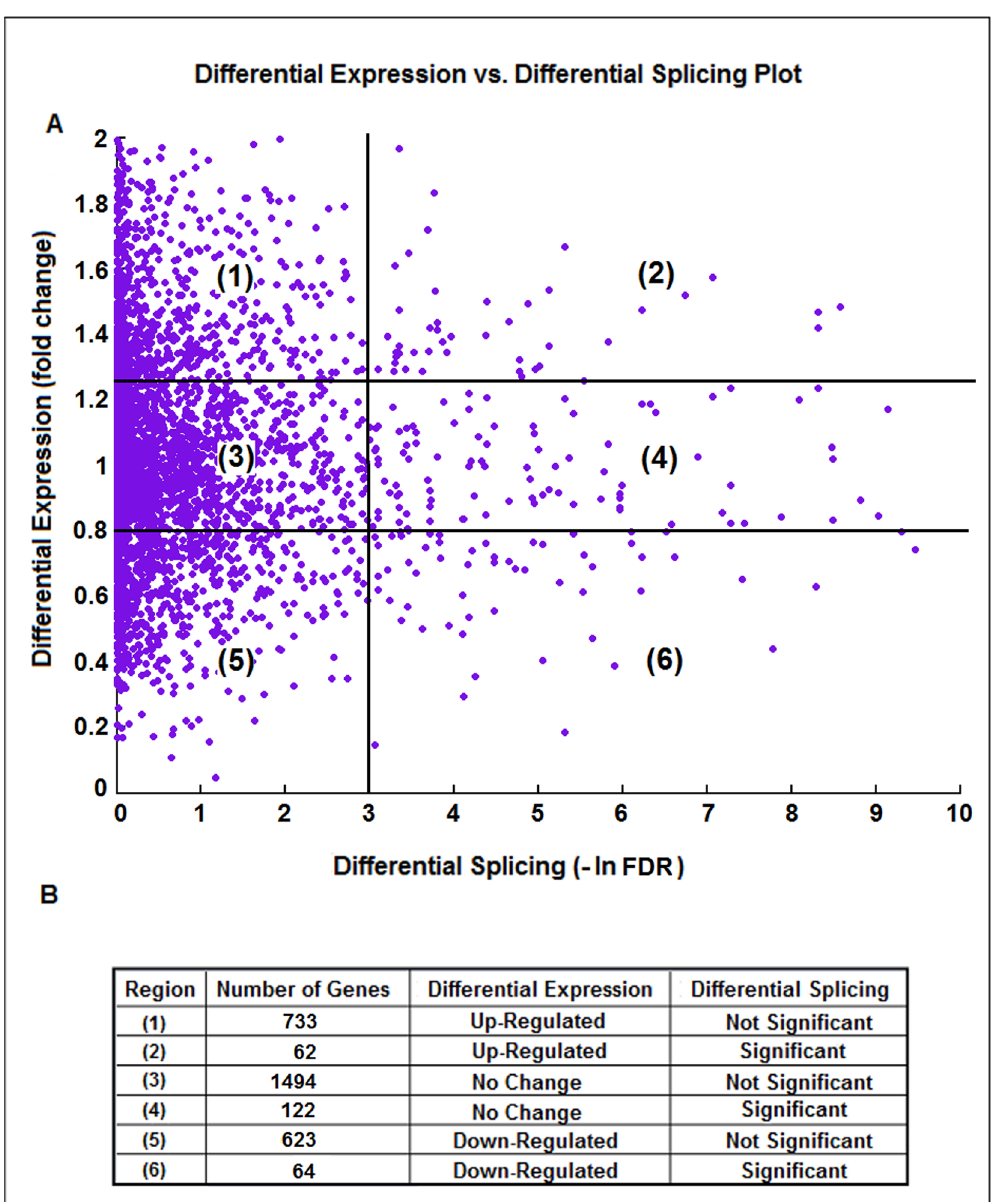
Figure 1. Joint analysis of differential expression and differential splicing between IPF lungs and controls. (A) Differential expression vs . Differential splicing plot. The panel is partitioned into 6 regions. (B) A table listing 6 regions representing the results of joint analysis of differential gene expression and differential splicing, and the number of genes within each region. Region 4 corresponds to the non-differentially expressed but differentially spliced genes that we carried out in-depth analysis.